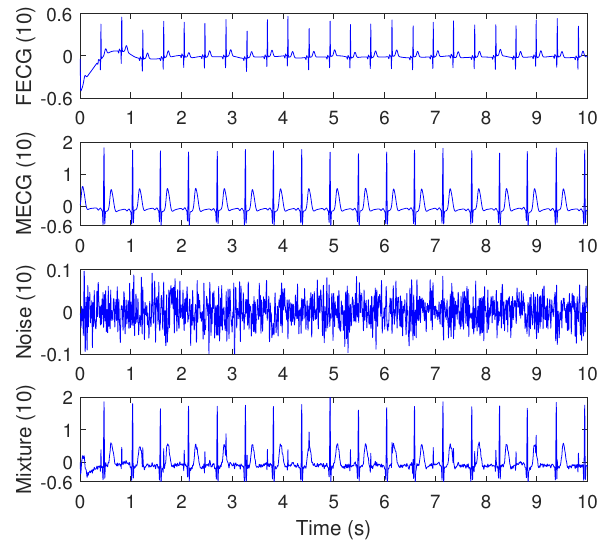
Figure 13. Synthesized abdominal FECG, MECG, and Noise signals (the three signals from the top), taken from channel (10), using Physionet/Fetal ECG Synthetic database (FECGSYNDB), considering simulated pregnancy number = 01, SNR = 12 dB, and event of MHR/FHR acceleration/deceleration plus noise. The corresponding paper file names are F0112, M0112, and N0112, according to Table 1. The signal number (4) from the top is the mixture signal after adding the FECG, MECG, and noise signals. The y -axis labels refer to the namess of signals taken from channel 10.